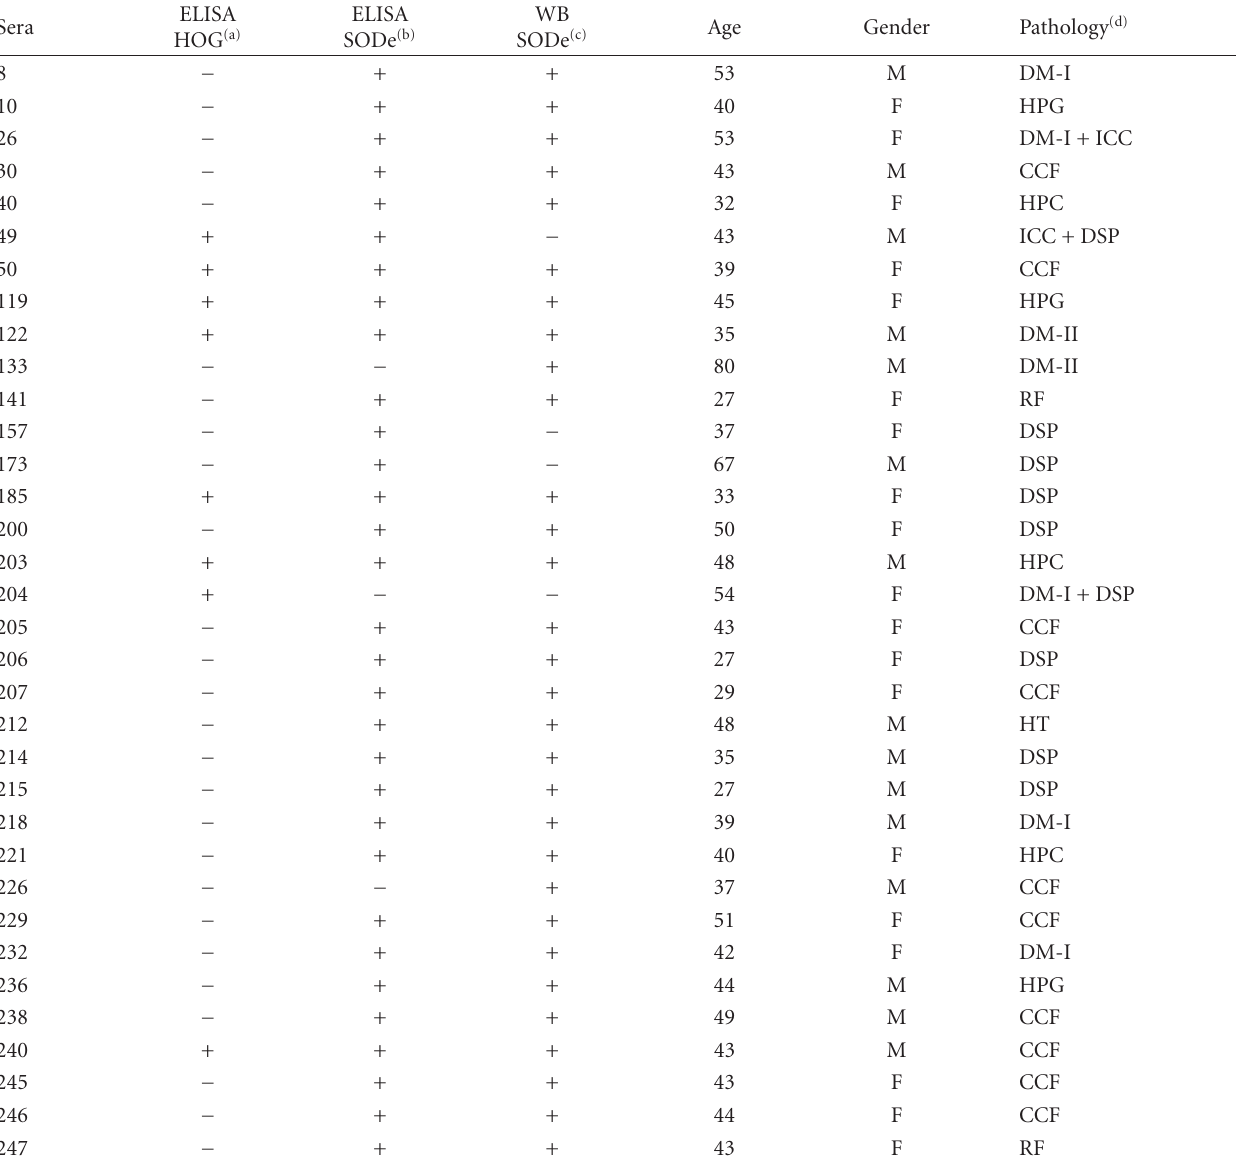
(a) ELISA-HOG: Enzyme-Linked Immunosorbent Assay (ELISA) using total parasite extract (HOG) of T. cruzi as antigen fraction. (b) ELISA-SODe: Enzyme-Linked Immunosorbent Assay (ELISA) using excreted superoxide dismutase (SODe) by epimastigotes of T. cruzi as antigen fraction. (c) WB-SODe: Western Blot (WB) using excreted superoxide dismutase (SODe) by epimastigotes of T. cruzi as antigen fraction. (d) Pathology abreviations: MD-I: mellitus diabetes type 1; MD-II: mellitus diabetes type 2; HPG: hipertrigliceridemia; CCF: chronic cardiac failure; HPC: hypercholesterolemia; DSP: dyslipidemia; RF: renal failure; HT: